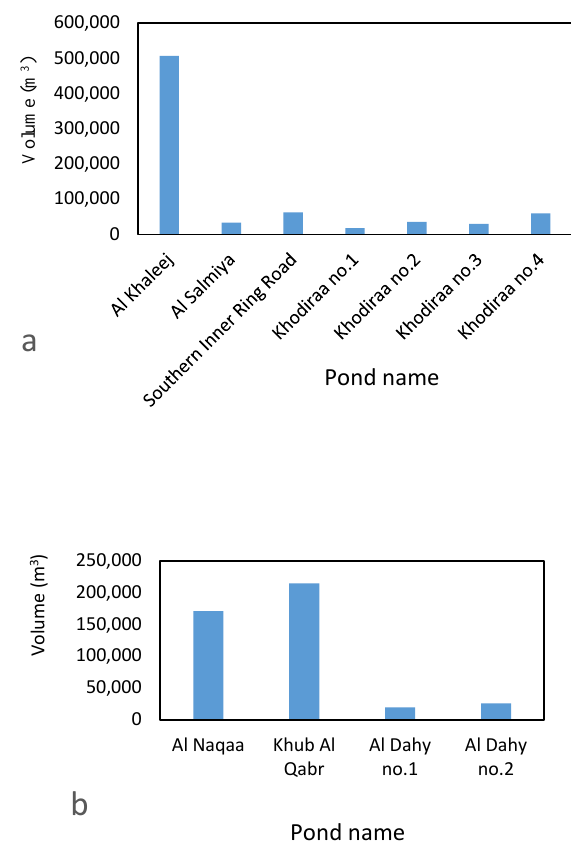
Figure 12. SewerGEMS results showing runoff from hydraulic model for pond systems, ( a ) volume of storm water at the Al Khaleej outlet; ( b ) volume of storm water at the Al Naqaa outlet.